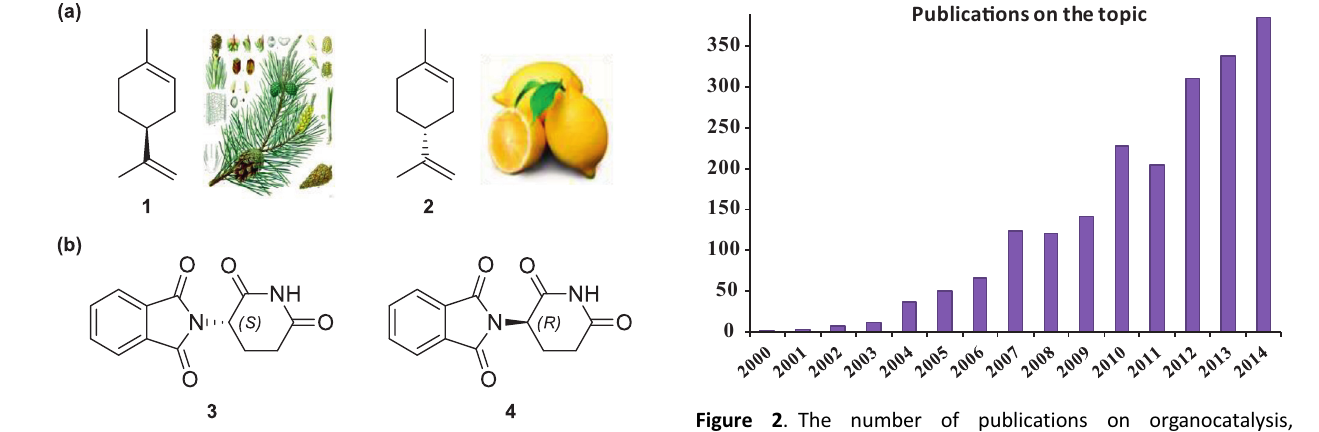
Figure 2 . The number of publications on organocatalysis, obtained by searching “ organocatalysis ” in Sci fi nder. For the year 2014, the number has been calculated until 15 December 2014, see Ref. [21]. (Figure 2) [21]. In one of his reference work, MacMillan pro-